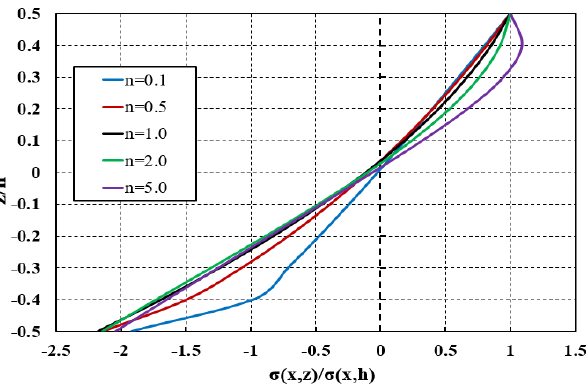
Figure 7. Normalized Axial stress σ xx distribution in simply supported P-FGM beam.